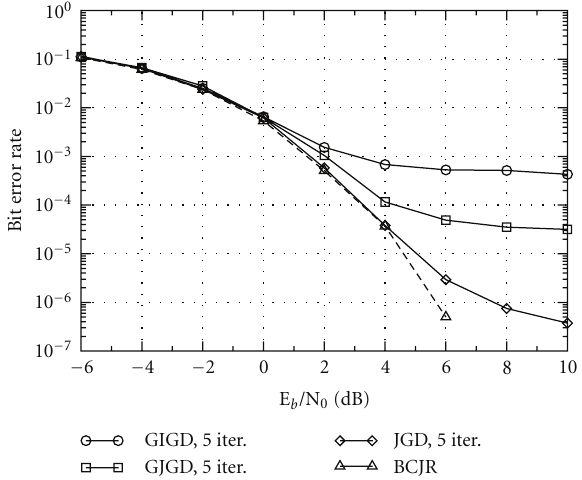
Figure 8: Performance of the three Gaussian detectors in an uncoded system, N T = N R = 4, L = 4, and K =